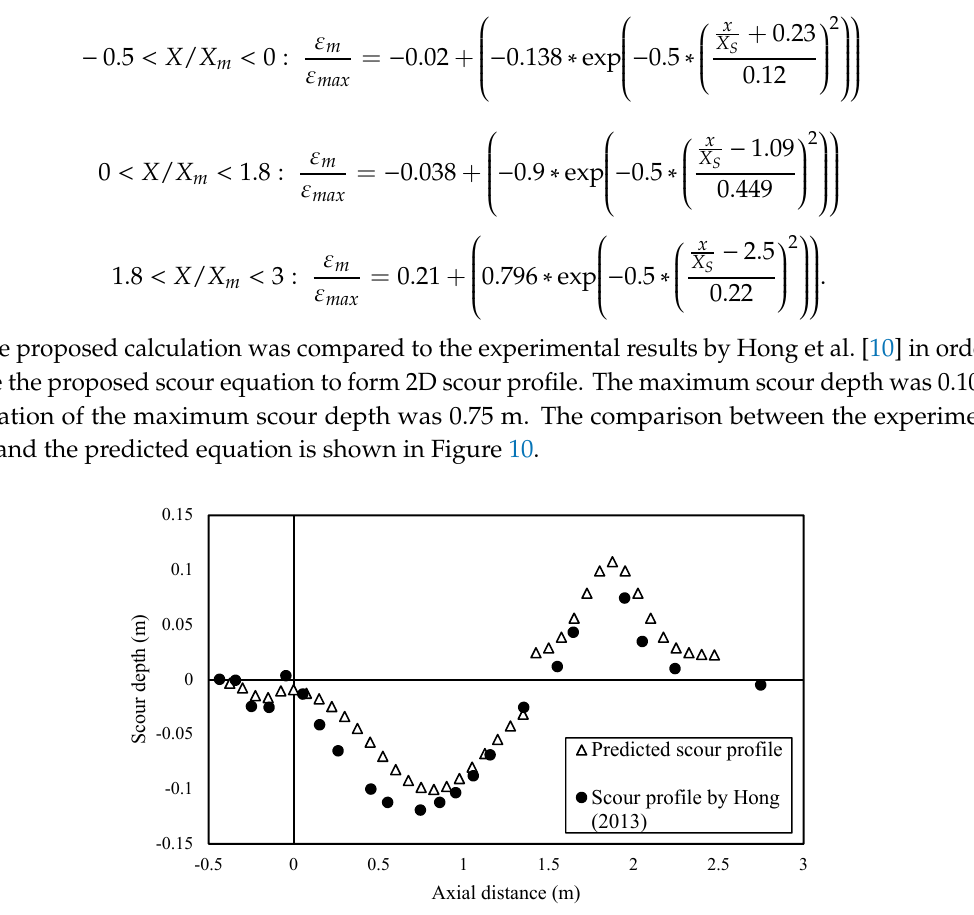
Figure 10. Comparison between the experimental values and the predicted